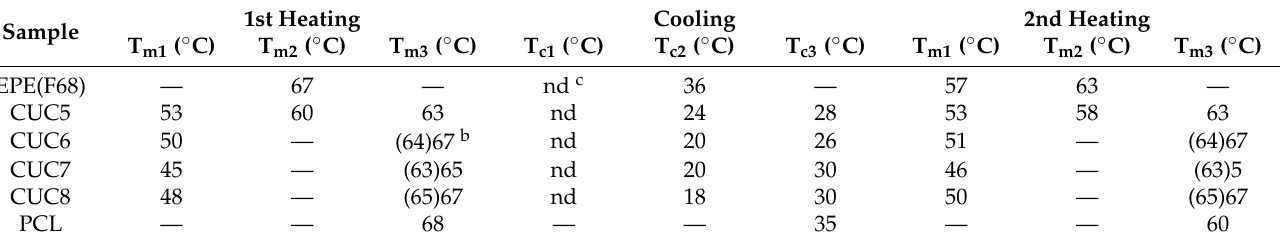
a T m and T c are melting and crystallization temperatures. the left side of the peak. c nd is not